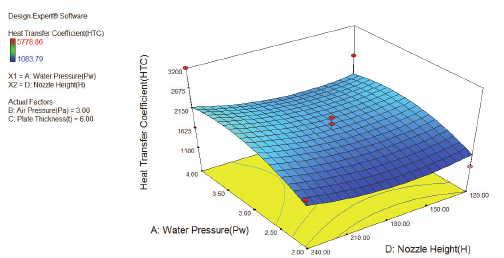
Fig. 5. Variation of HTC with respect to air pressure and plate